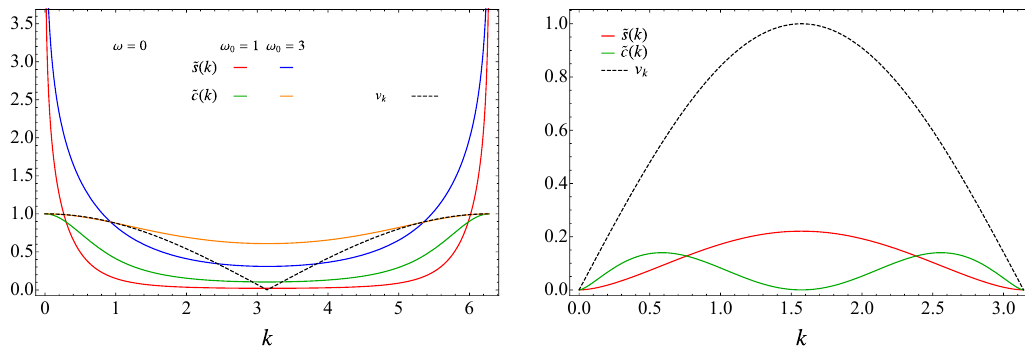
Figure 4 . The densities of the quasi-particles (4.18) and the corresponding velocity for the quantum quenches discussed in section 4 and section 5 for the bosonic (left panel) and the fermionic (right panel) chain, in terms of the momentum k